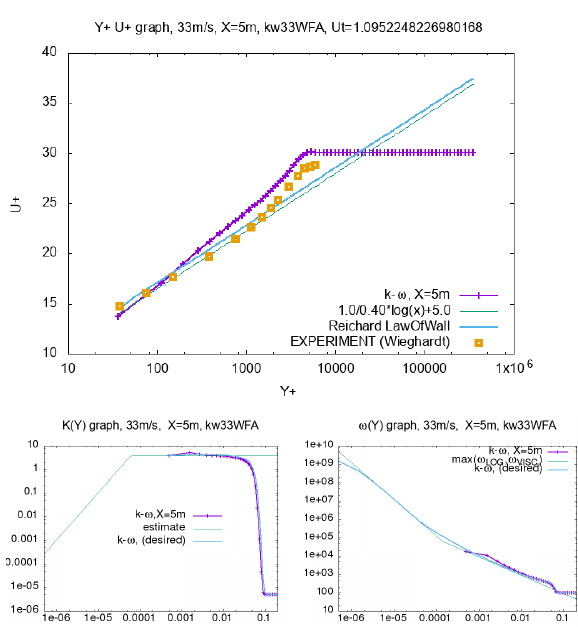
Fig. 1. CFD simulations, standard wall function, height of the first cell 0.001m, regime U ∞ = 33 m.s − 1 . Graph for the U + (com- parison with experimantal data), k ( Y ) ,ω ( Y ) in the vertical cut at x =